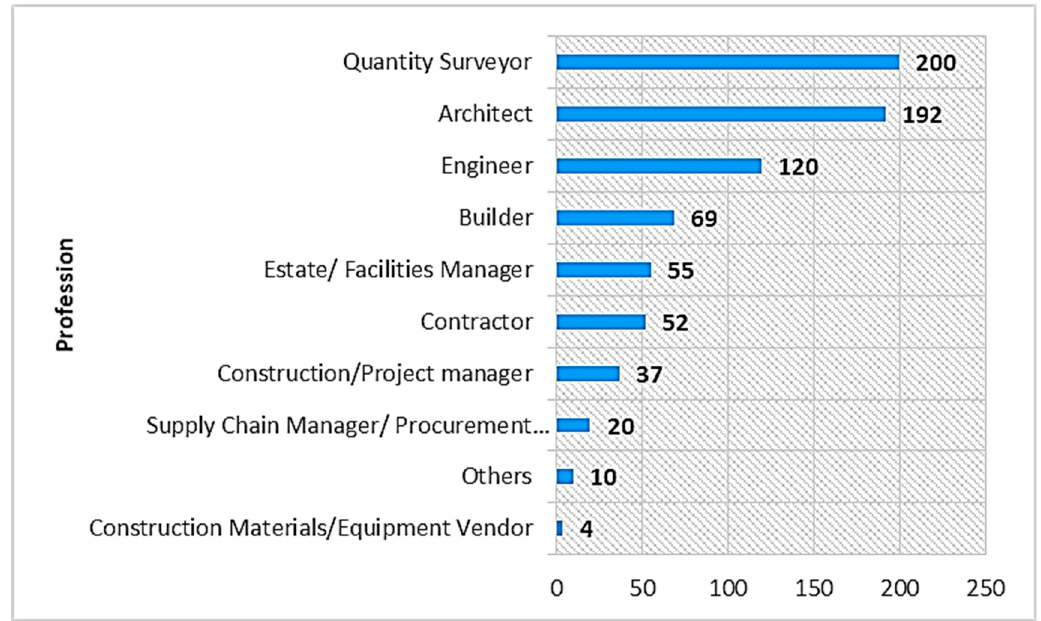
Figure 5. Actual users of e-Procurement systems according to profession.